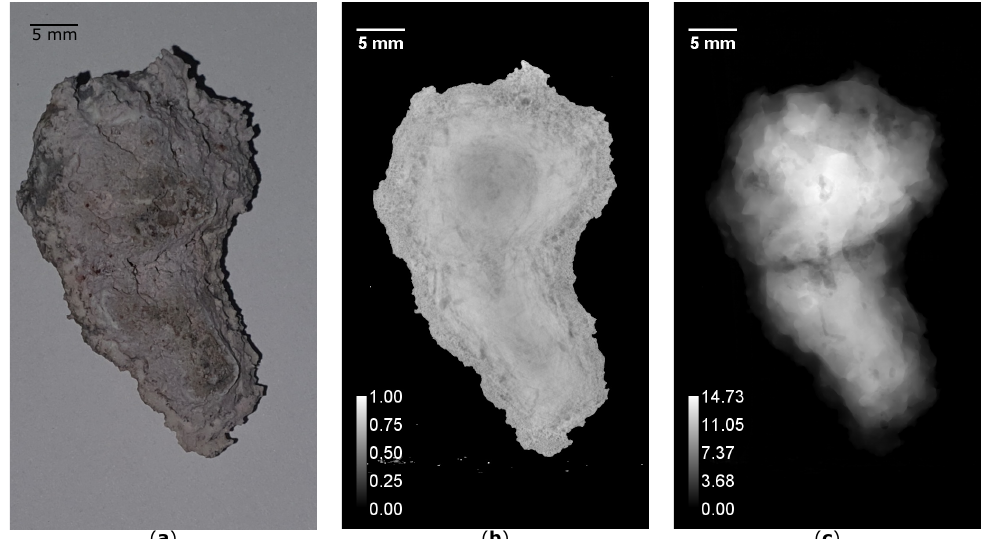
Figure 9. Images of a raft from alumina fines type A. ( a ) Image of raft from above. ( b ) Projected CT image of the raft seen from above, displaying the average density. ( c ) Projected CT image of the raft seen from above, displaying the thickness of the raft. The scale is given in